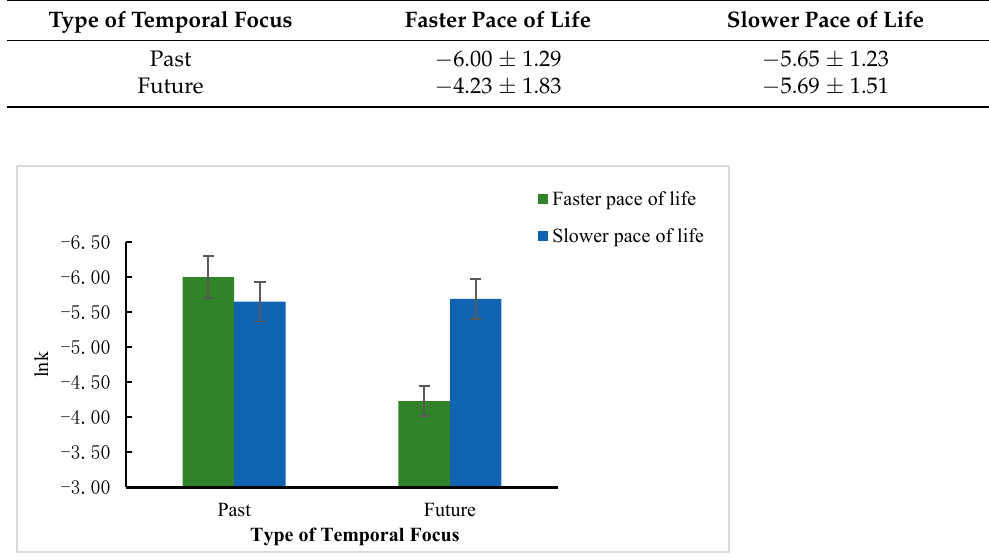
Figure 3. Comparison of participants’ intertemporal decision scores (lnK) under different paces of life and different temporal focuses. Table 4. Intertemporal decision scores (lnK) for participants with fast and slow paces of life in dif- ferent temporal focus conditions ( M ± SD ).